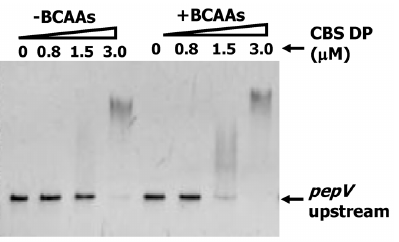
Figure 2. Electrophoresis mobility shift assay showing DNA binding. Electrophoresis mobility shift assay using the purified CBS domain protein (CBSDP) and a 309 bp DNA fragment from upstream of the pepV gene in the presence or absence of 10 mM BCAAs and various